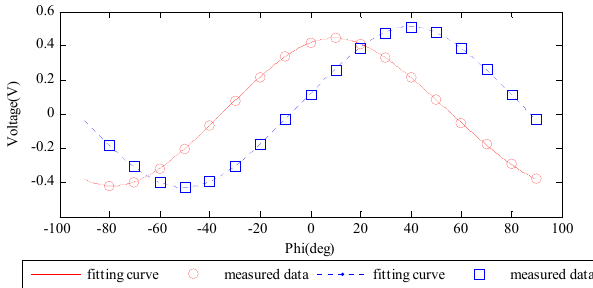
Figure 6. The fitting curve of the output voltage of the two groups of orthogonal channels. The red line and circles represent the fitting curve and measured output voltage of channels 1/3, the blue dashed line and squares represent channels 2/4.